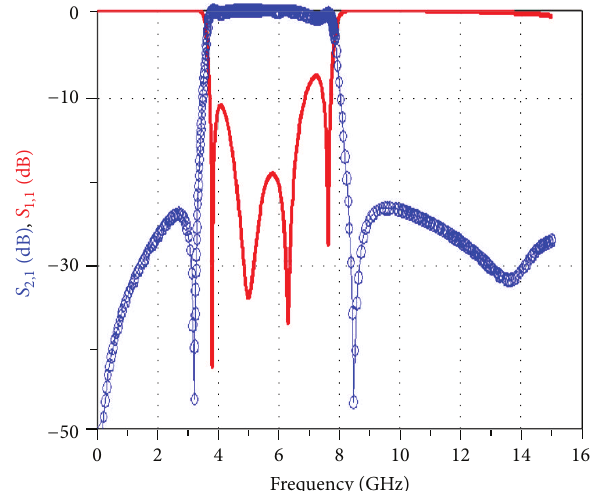
Figure 11: The simulated frequency response of the broadband band-pass filter designed using a MMR resonator in the workspace of ADS versus return losses (𝑆 11 ) and insertion losses (𝑆 21 ) in a range of 0–16GHz.